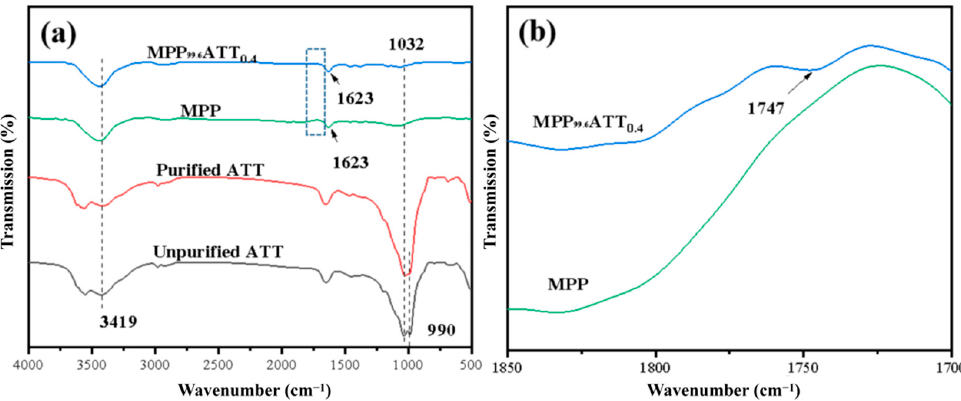
Figure 3. FTIR spectra: ( a ) MPP 99.6 ATT 0.4 , MPP, purified ATT, and unpurified ATT for wavenumbers 500–4000 cm − 1 ; ( b ) MPP 99.6 ATT 0.4 and MPP for wavenumbers 1700–1850 cm − 1 .